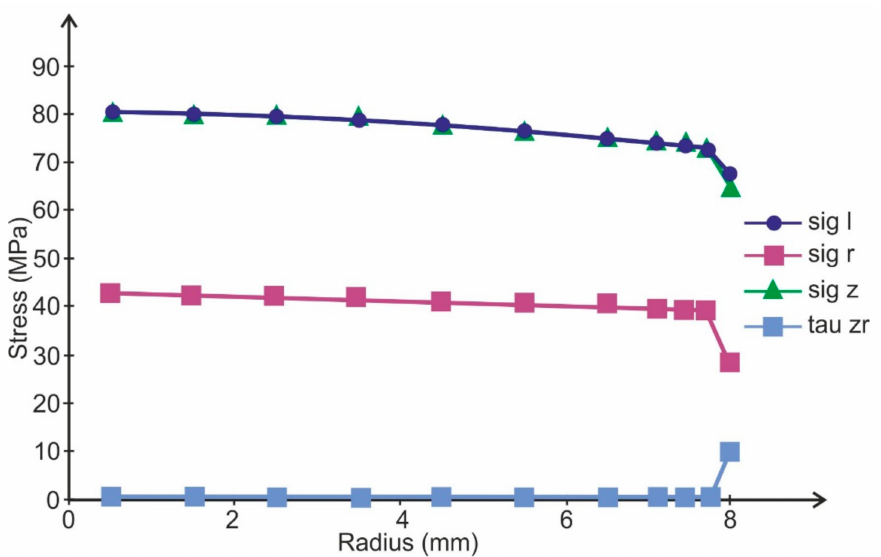
Figure 3. Stresses distribution in the adhesive layer of the butt specimen (sig I—maximal principal stress, sig r—radial stress equal circumferential stress, sig z—axial stress, tau zr—shear stress, the adhesive was modeled by three layers of